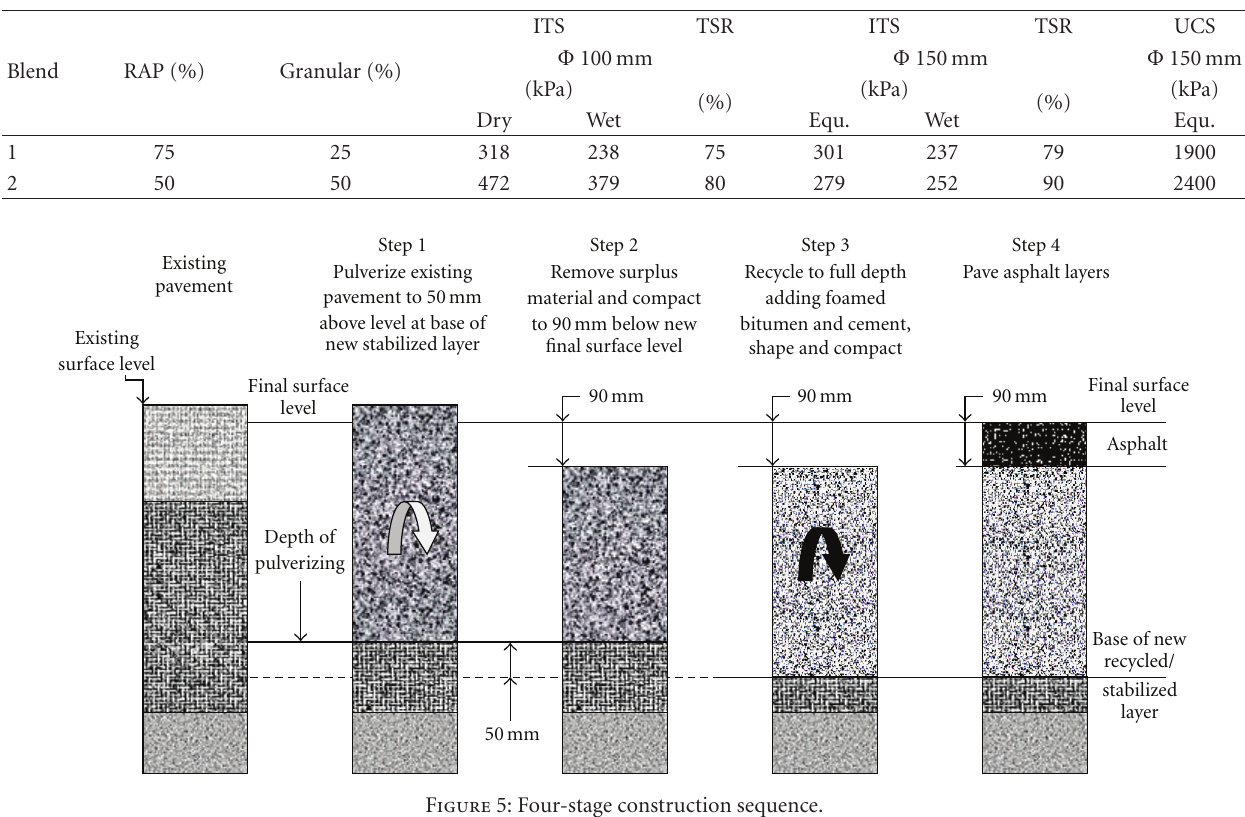
Table 1: Summary of foamed asphalt mix design results.